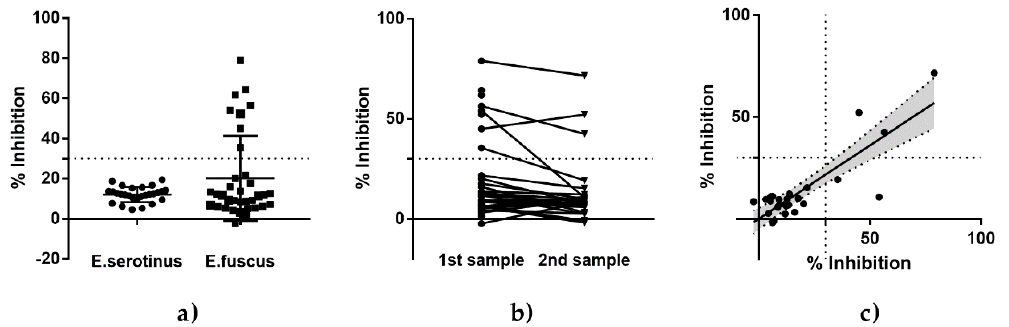
Figure 3. ELISA results (% inhibition) for sera from Eptesicus serotinus and Eptesicus fuscus taken prior to experimental studies. The threshold of 30% inhibition as a cut-off for seropositivity is indicated as a dashed line. ( a ) ELISA results for all sera tested stratified by species. For Eptesicus fuscus, serum was taken at two occasions prior to infection. The comparative results between sampling point one and two are presented on an individual level ( b ) and were analyzed by a linear regression model ( c ). The slope (solid line) and the 95% CI (gray zone) are indicated. The results for the second sampling can be calculated using the formula Y = 0.7205 X + 0.07097, with a slope that is highly significant divergent from zero ( p < 0,0001).